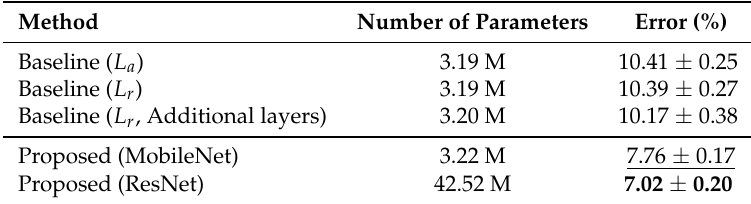
Table 2. Comparison of GSD prediction errors and the number of parameters for the log GSD scale dataset